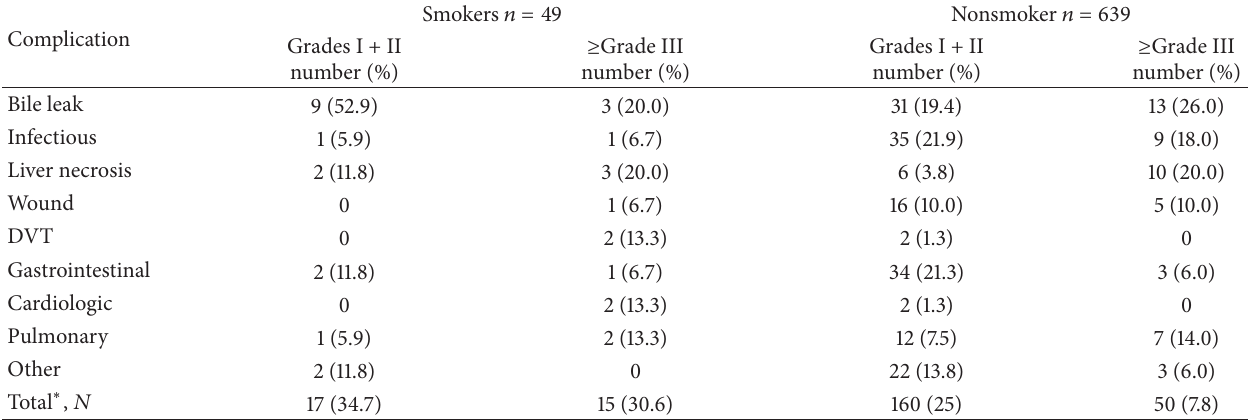
Table 6: Classification of postoperative complications in smokers versus nonsmokers.